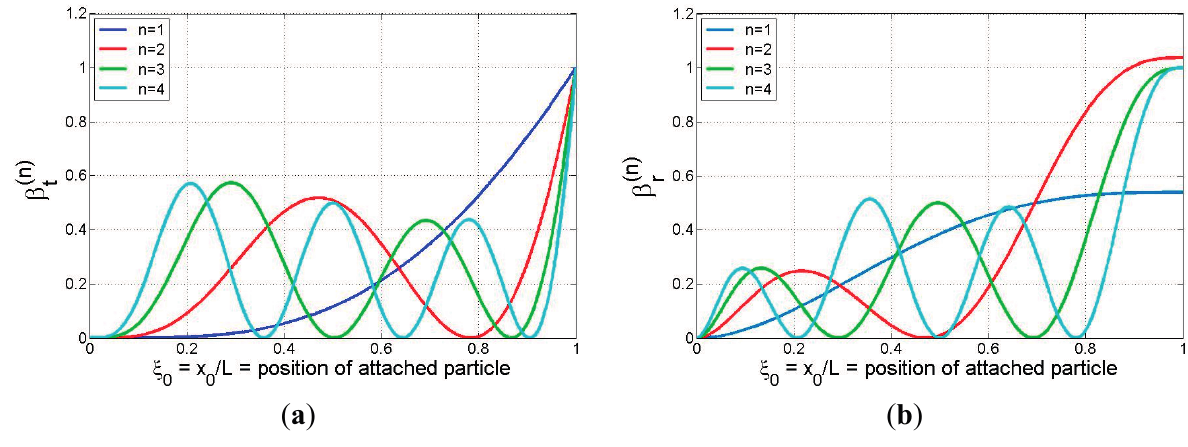
( ) β ξ , and ( b ) rotational inertia ( ) n 0 t ξ ξ= on a cantilever (modes 0